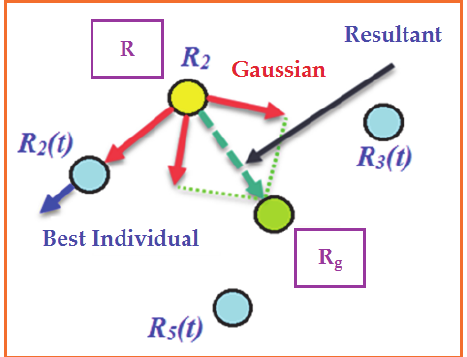
Figure 1. Mathematical expression of Gaussian mutation in IHLOA.